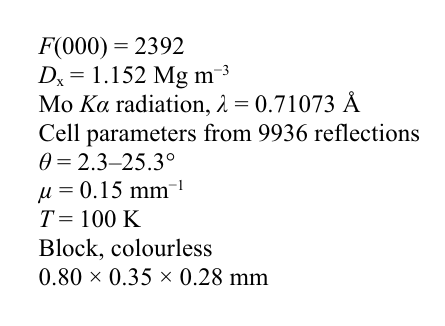
Packing diagram seen along the b axis. Dashed lines represent intermolecular C—H··· π interactions. Oxybis(dimesitylborane) dichloromethane hemisolvate Crystal